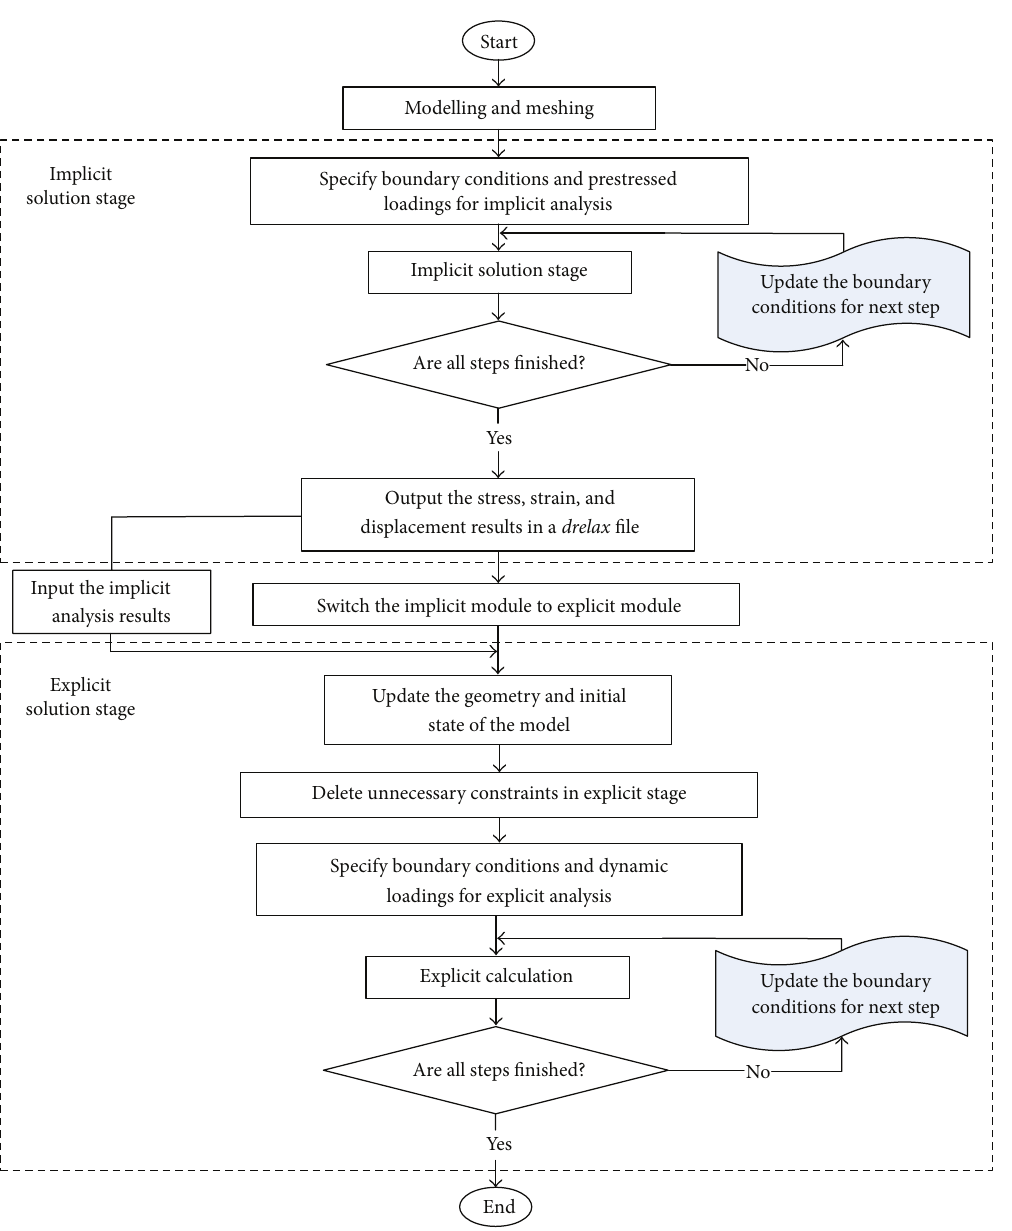
Figure 3: Flow chart for implicit to explicit sequential solution